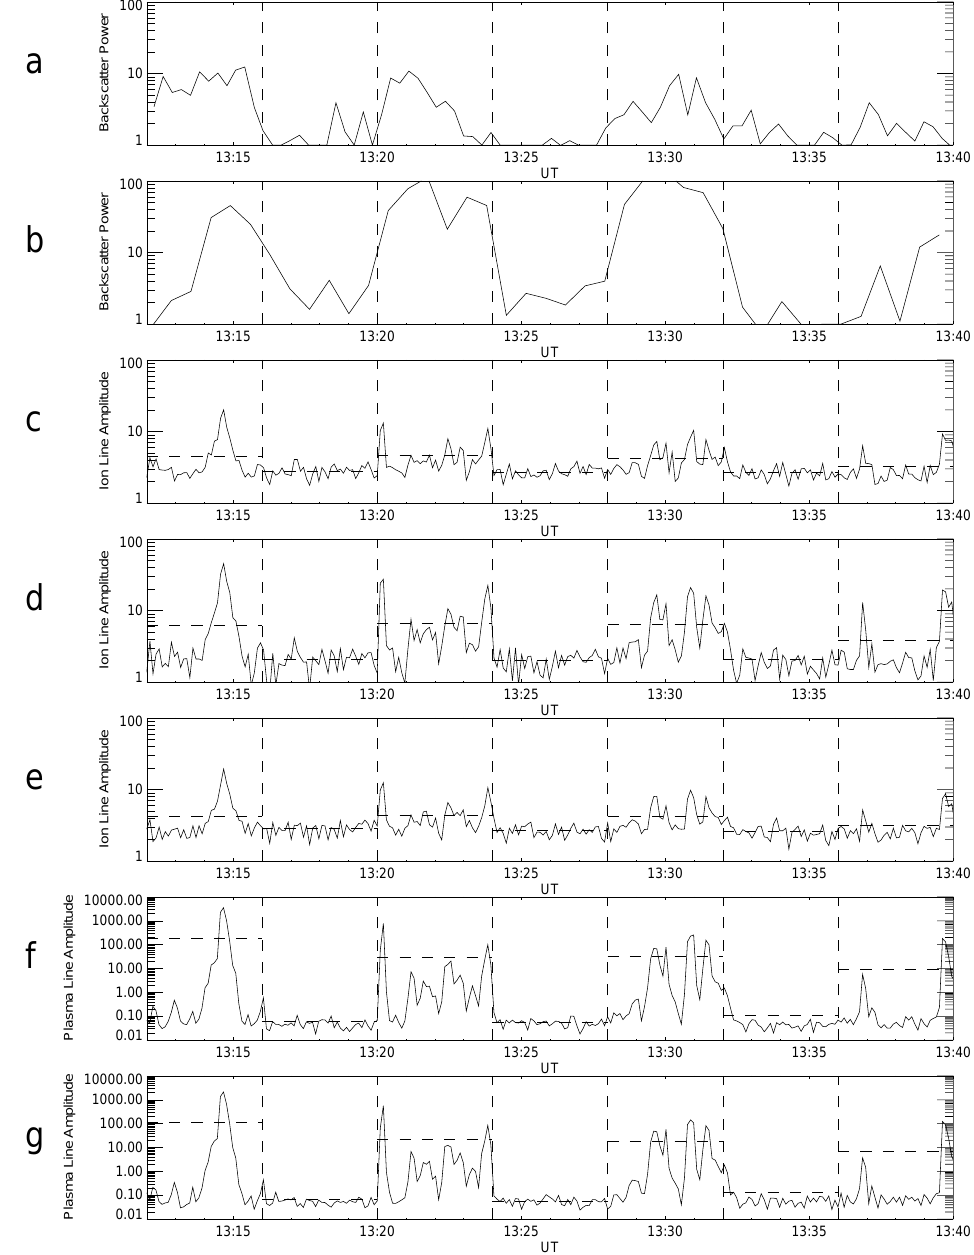
Fig. 17. Time series of amplitudes of CUTLASS Finland (panel a ) and Iceland (panel b ) backscatter powers, together with ESR ion- and plasma-lines for 13:12–13:40 UT, 1 October 2004. Panel (c) contains the upshifted ion-line; (d) , the unshifted ion-line centre frequency; (e) , the down shifted ion-line; (f) , the upshifted plasma-line and (g) , the downshifted plasma-line.